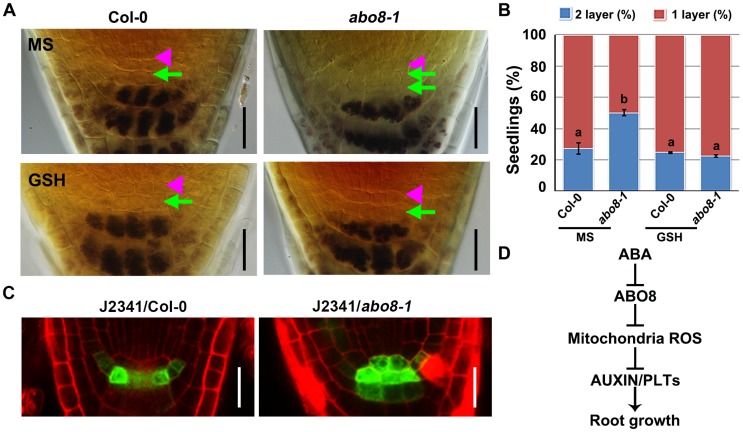

abo8 mutation delays the distal stem cell (DSC) differentiation.A. Differentiation status of DSC in 5-day-old seedlings on MS medium or MS medium with 300 µM GSH. DSC (green arrowheads) are characterized as cells between the QC (pink triangle) and the starch containing differentiated columella cells. Bars = 20 µm. B. Quantitative evaluation of DSC layers in A. About 30 roots were examined for each biological repeat, three experiments were done with similar results. Values are means ±SE from one experiment. Means in different letters are P<0.01. C. The expression of DSC marker J2341 in roots of the wild type and abo8-1 mutants. Bars = 20 µm. D. A proposed model for ABO8 in root growth. ABO8 is downreguated by ABA. ABO8 negatively modulates mitochondria ROS, and ROS negatively modulate auxin level and signaling to control PLTs expression. It is likely that ROS also directly regulate PLT1 as posttranscriptional level.